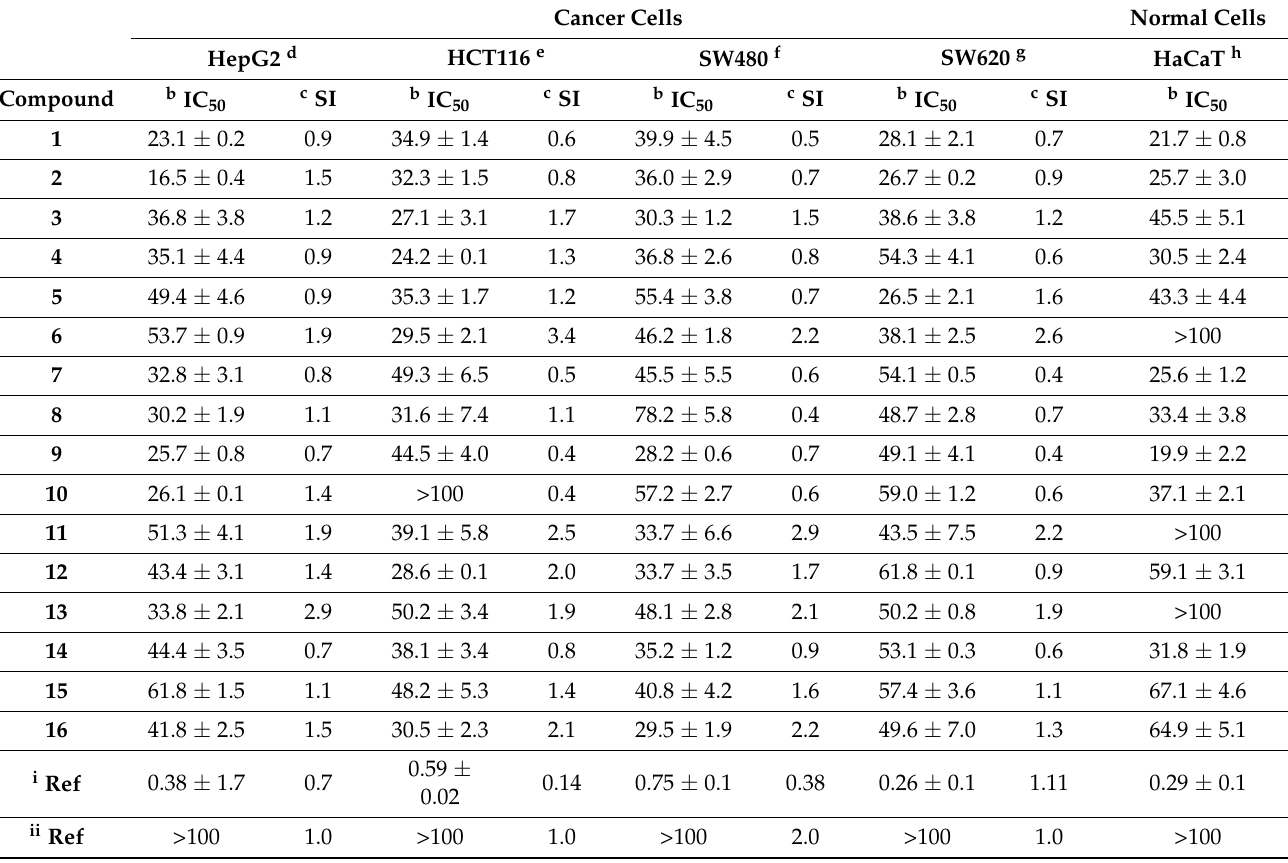
Table 7. Cytotoxic activity of studied compounds estimated by the MTT assay a . Cancer Cells Normal